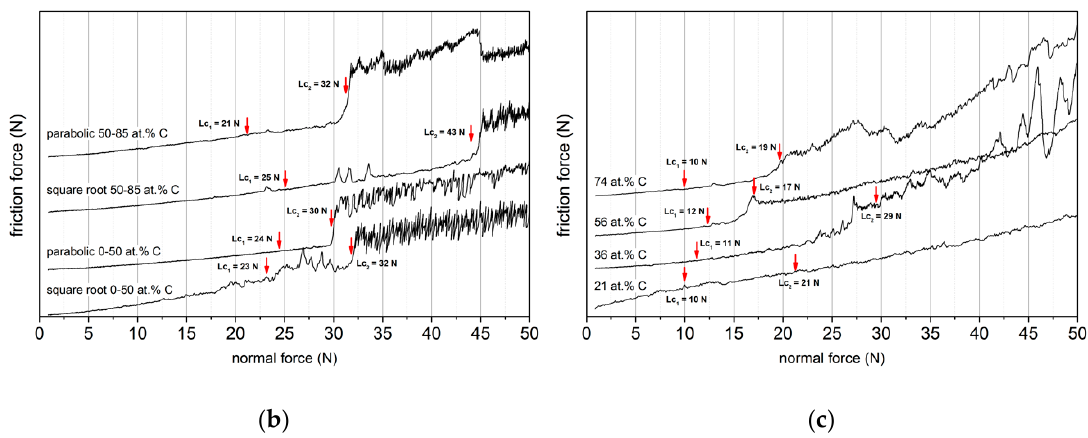
Figure 11. Scratch test results: ( a ) values of critical loads determined, dependence of the friction force on the normal force loading the indenter for ( b ) gradient coatings, and ( c ) single-layer coatings.